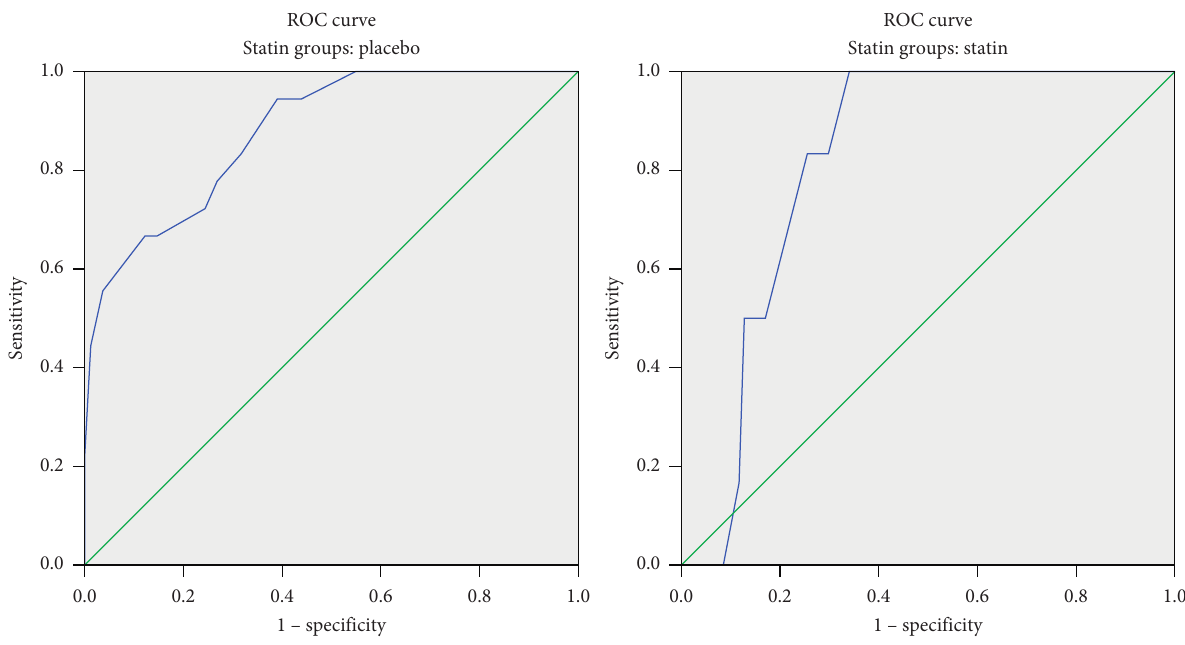
Figure 1: AUC regarding X-ray time of